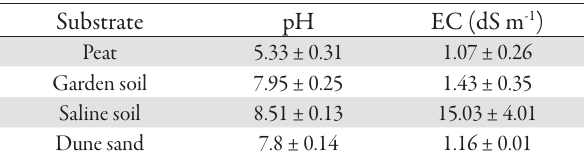
Tab. 1. pH and electrical conductivity (EC) in saturated extract (mean and standard deviation) of the four substrate types used for plant